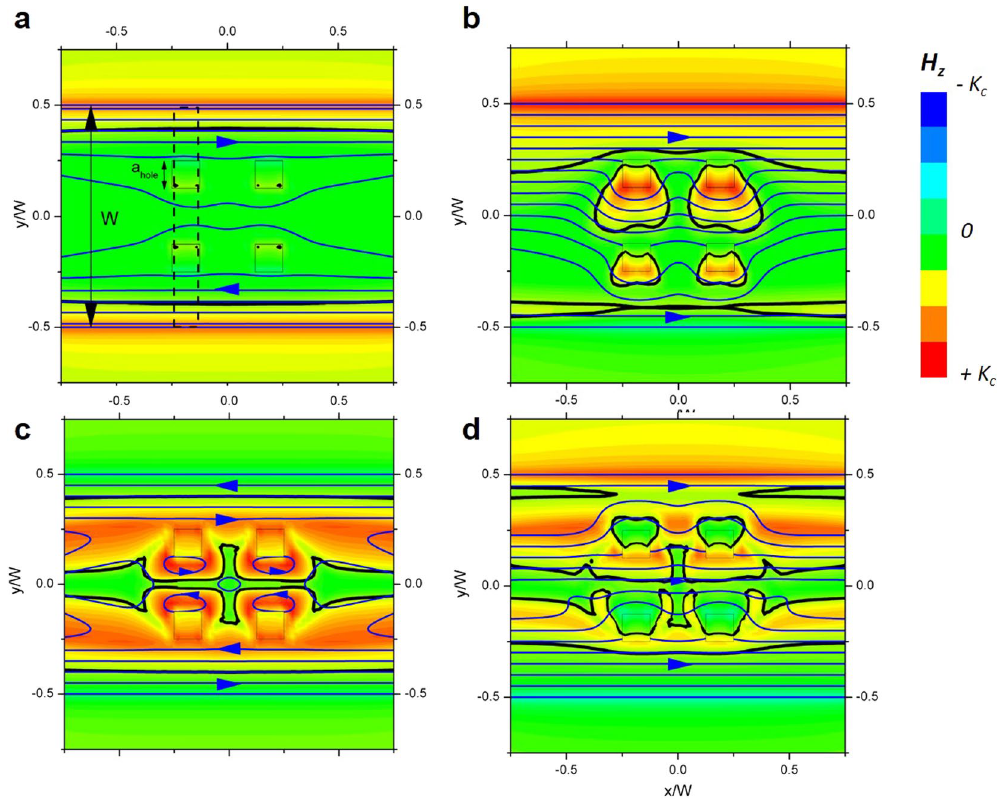
Figure 3. Inhomogeneous SC magnetic field distribution. Out-of-plane magnetic field H z (colour scale) and current stream lines (blue lines, arrows indicate direction of current) induced in a thin straight superconducting film, of uniform thickness t , width W and constant critical current J c , with four symmetrical square antidots. For a uniform applied perpendicular positive magnetic field H a = 0.3 K c (being K c = J c t ) ( a ) after zero field cooled and ( c ) after applying a positive field to saturate the sample and then decreasing down to H a . ( b ) and ( d ) applying a transport current I = 0.7 K c W in situation reached in (a) and ( c ), respectively. Thick black lines separate the regions with H z < H a from H z > H a